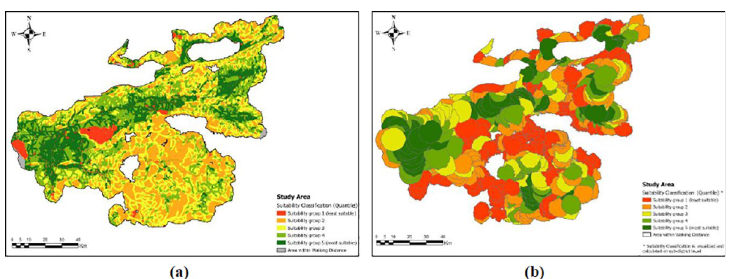
Fig 1. Suitability maps for agricultural development (warm colors represent the least suitability classes whereas cool colors represent the highest